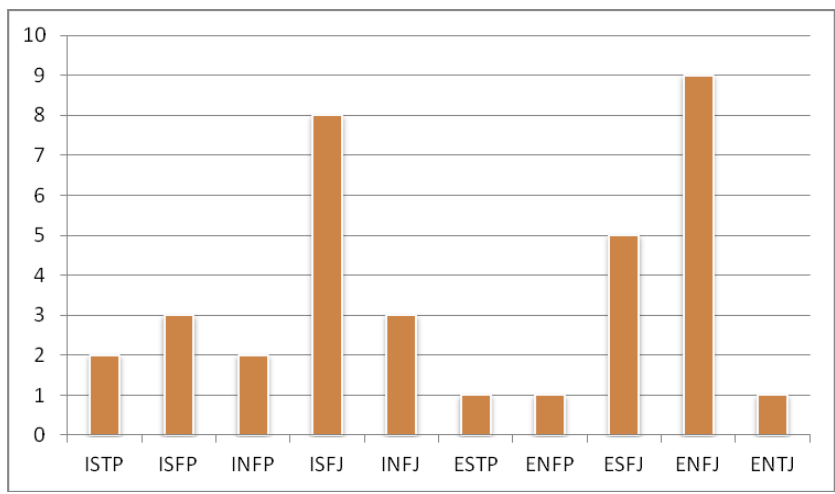
Figure 2. Personality type distribution (total: 35)